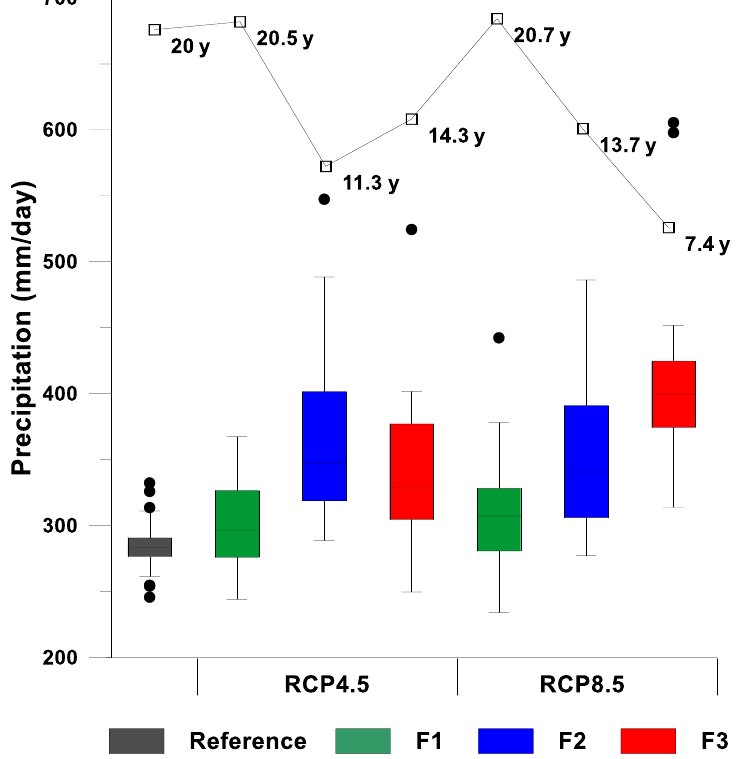
Figure 9. Change in 20-year precipitation and return period in Imjin River Basin.